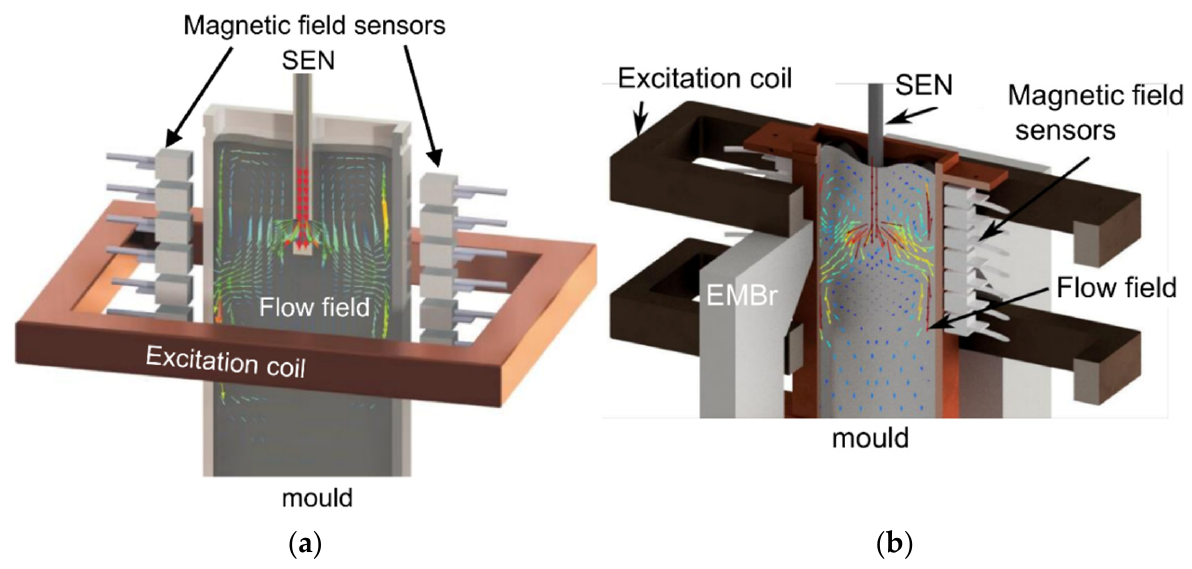
Figure 5. Schematic sketch of a CIFT sensor arrangement for a model of a continuous casting mold with a cross-section of 140 mm × 35 mm: ( a ) without an EMBr; ( b ) with an EMBr.